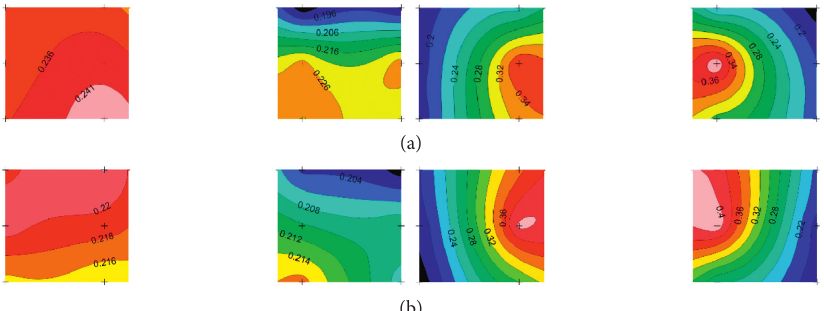
Figure 19: Fluctuating wind pressure coefficients of wall CD in the y -direction. (a) Wall CD at the upper opening in the model of L-3. (b) Wall CD at the lower opening in the model of